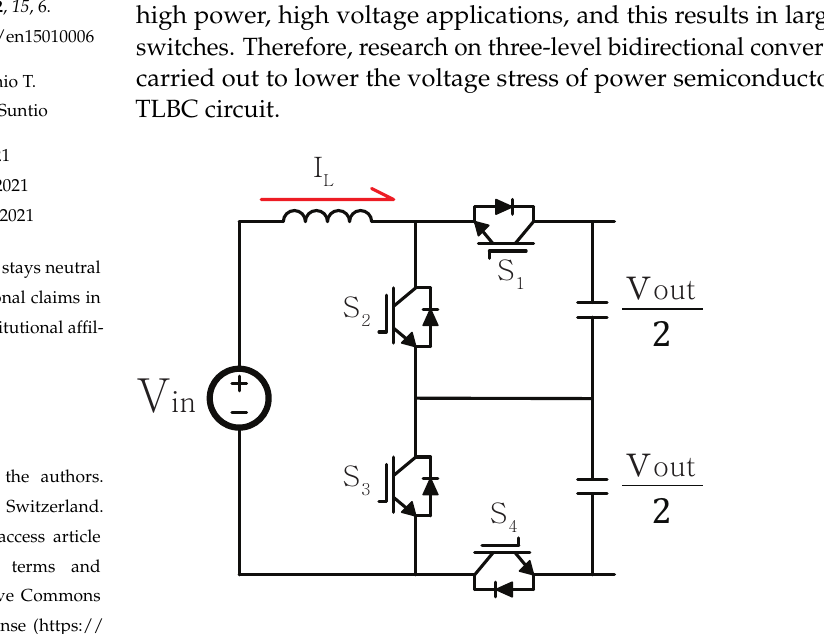
Figure 1. Single-module TLBC circuit